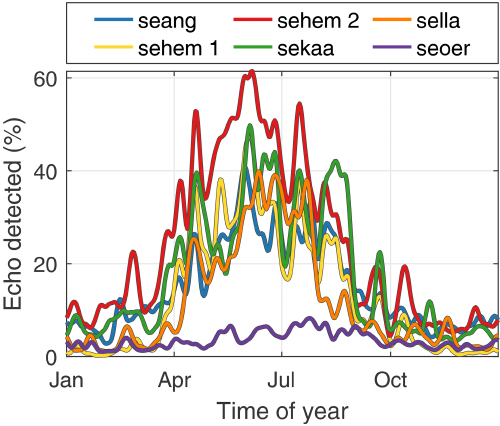
Figure 6. Relative frequency of detected echoes from the selected groups of radar cells as a function of the time of